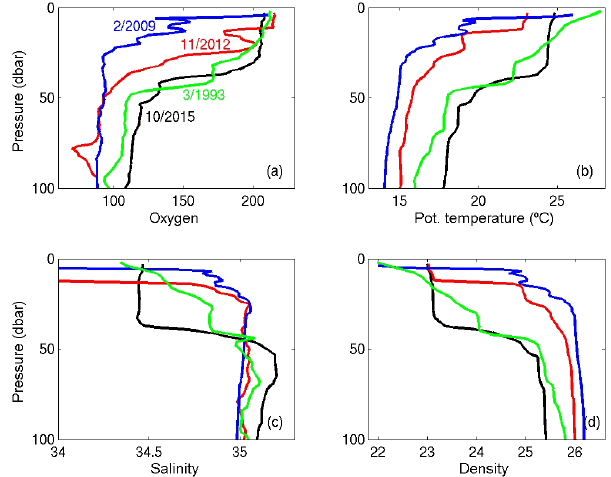
Figure 5. Same as Fig. 4 but for 100 to 400m